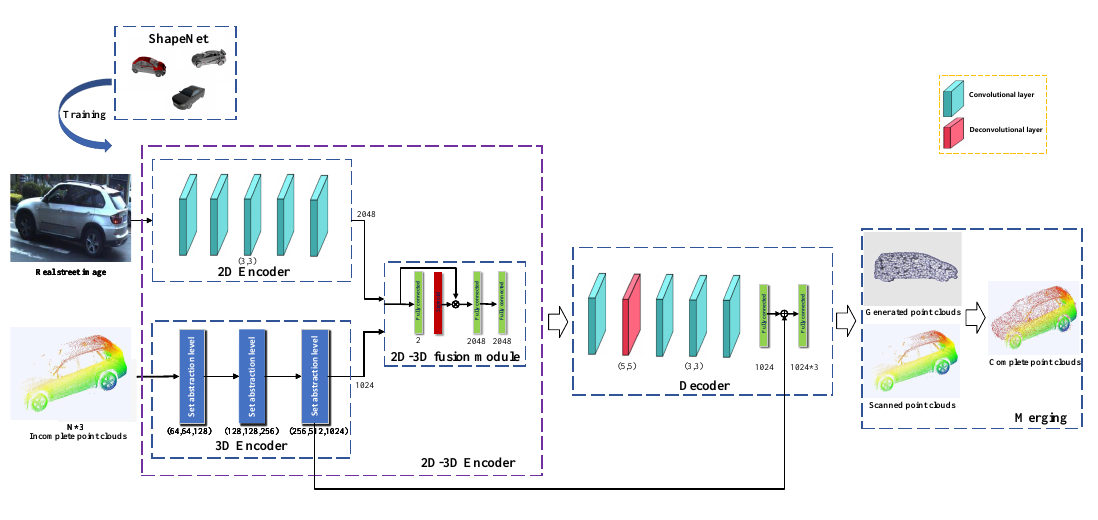
Figure 3. The framework of PCCNet